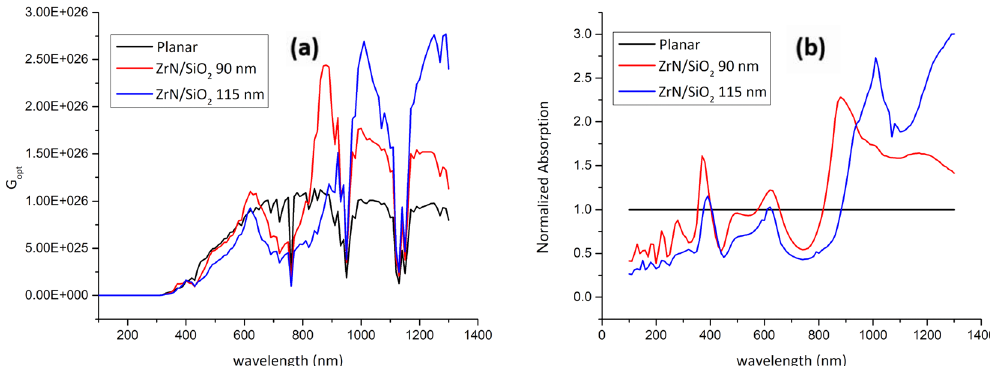
Figure 10. ( a ) Optical carrier generation rate ( G opt ) and ( b ) normalized light absorption profiles for planar and ZrN/SiO 2 -decorated PSCs.